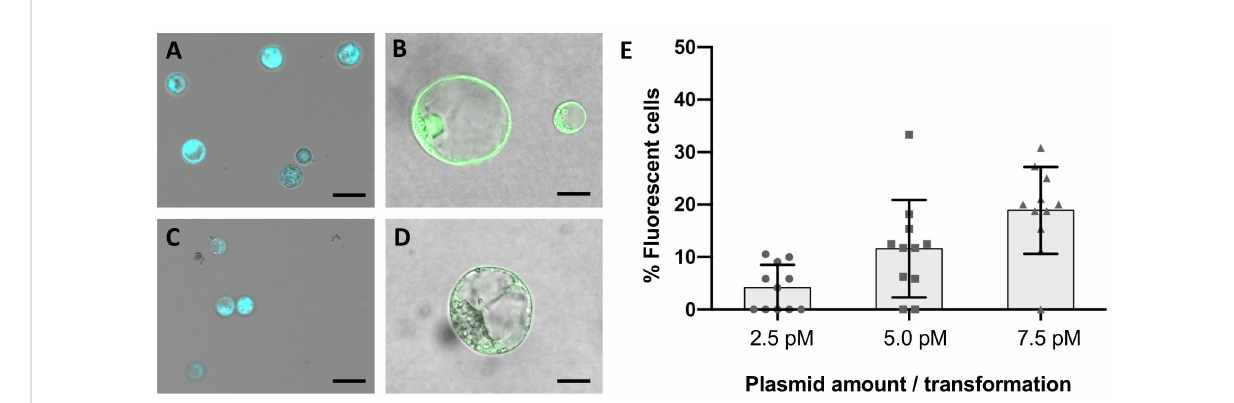
plasmid containing a 35S::GFP expression cassette and embedded in droplets of low melting point agarose for short-term culturing. GFP fl uorescence was detected in Crimson s. (B) and Sugraone (D) samples 24 hours after transformation. Black bars represent 50 m m and 10 m m respectively in a-c and b-d. Plot representing the percentage of GFP- fl uorescent cells detected in protoplasts suspension when transformed with increasing concentrations of plasmid (E) . Error bars represent the standard deviation.